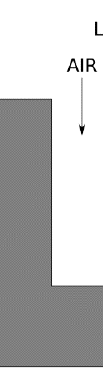
Fig. 1. A. Hoxie et al - CF atomizer . The most significant outcome of their study is that, even for large flow rates, d32 values remain at or less than 20 microns, despite using GLR values less than 20%. The high sensitivity of the d32 to GLR suggests that much smaller values of d32 may be attained without significant increases in GLR. Efficiency over a COM atomizer is increased by nearly 100%. The authors describe this performance trend as increasing with increasing viscosity, but they do not know the reason for this